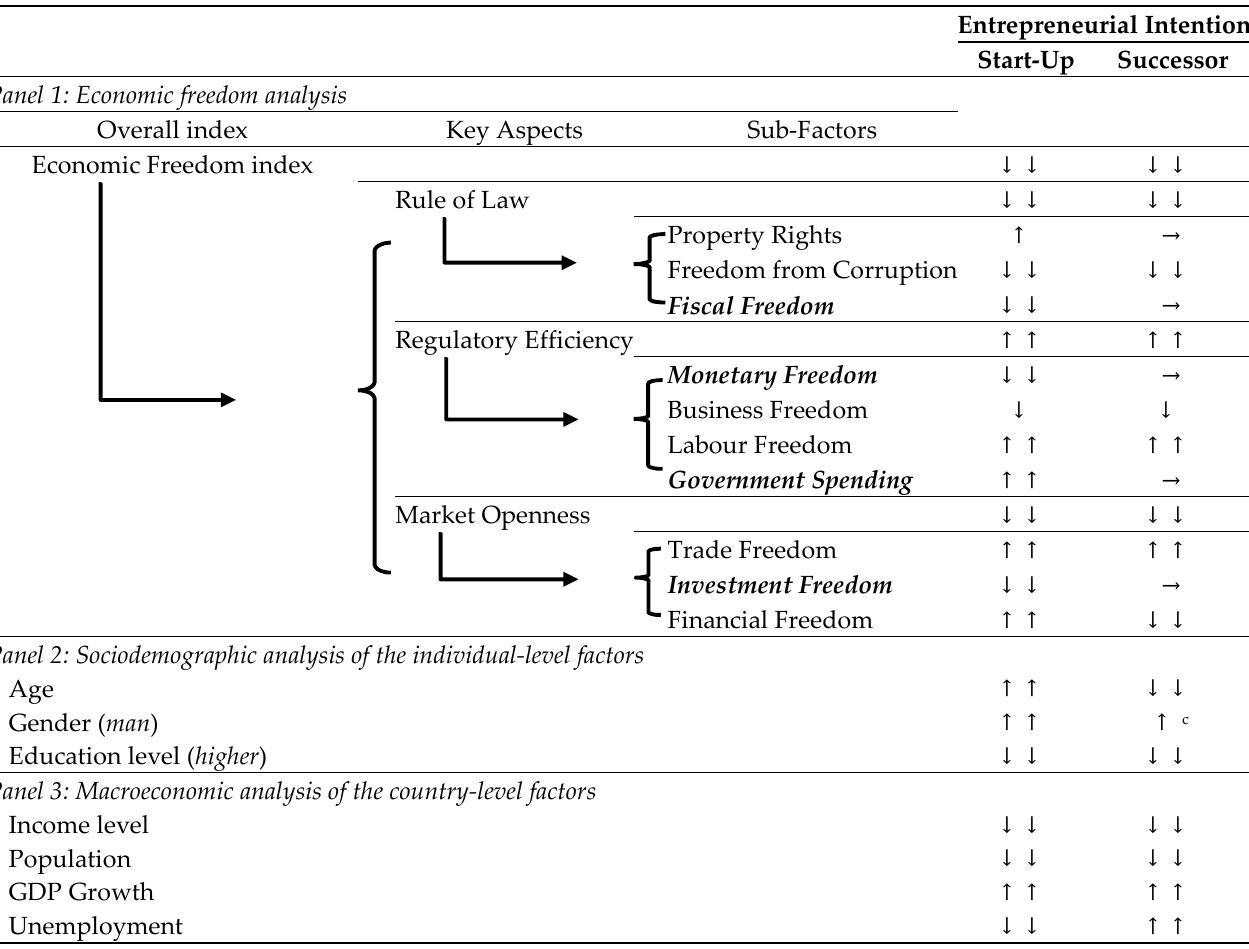
Table 7. Summary of the results.